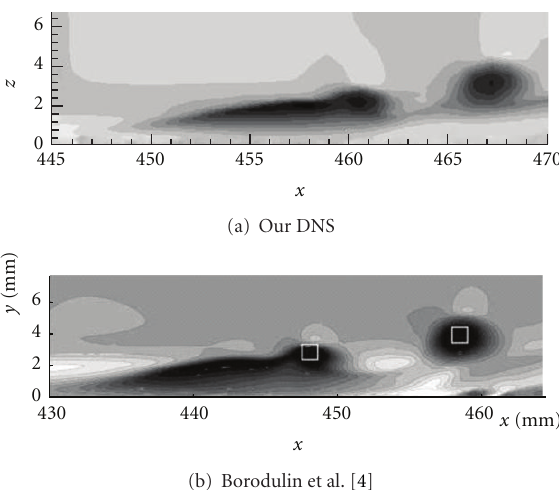
Figure 9: Qualitative comparison of contours of streamwise velocity disturbance u in the ( x , z )-plane (light shades of gray correspond to high